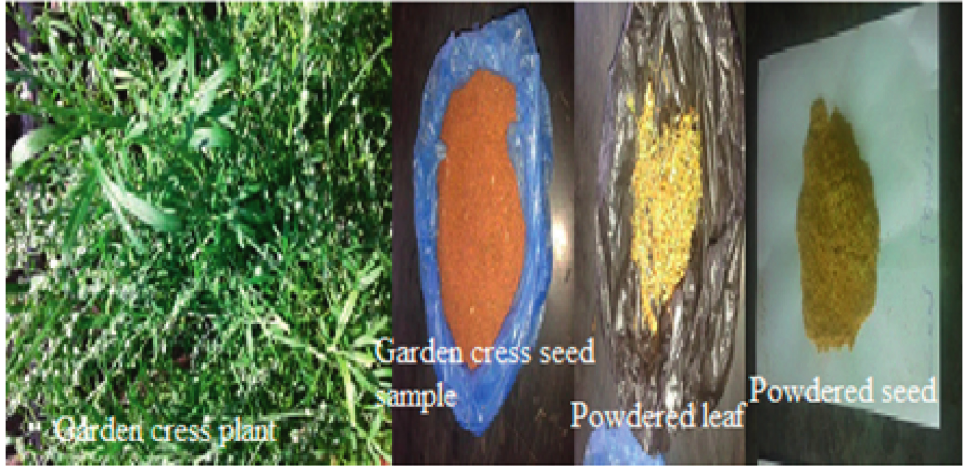
Figure 1: Sample garden cress